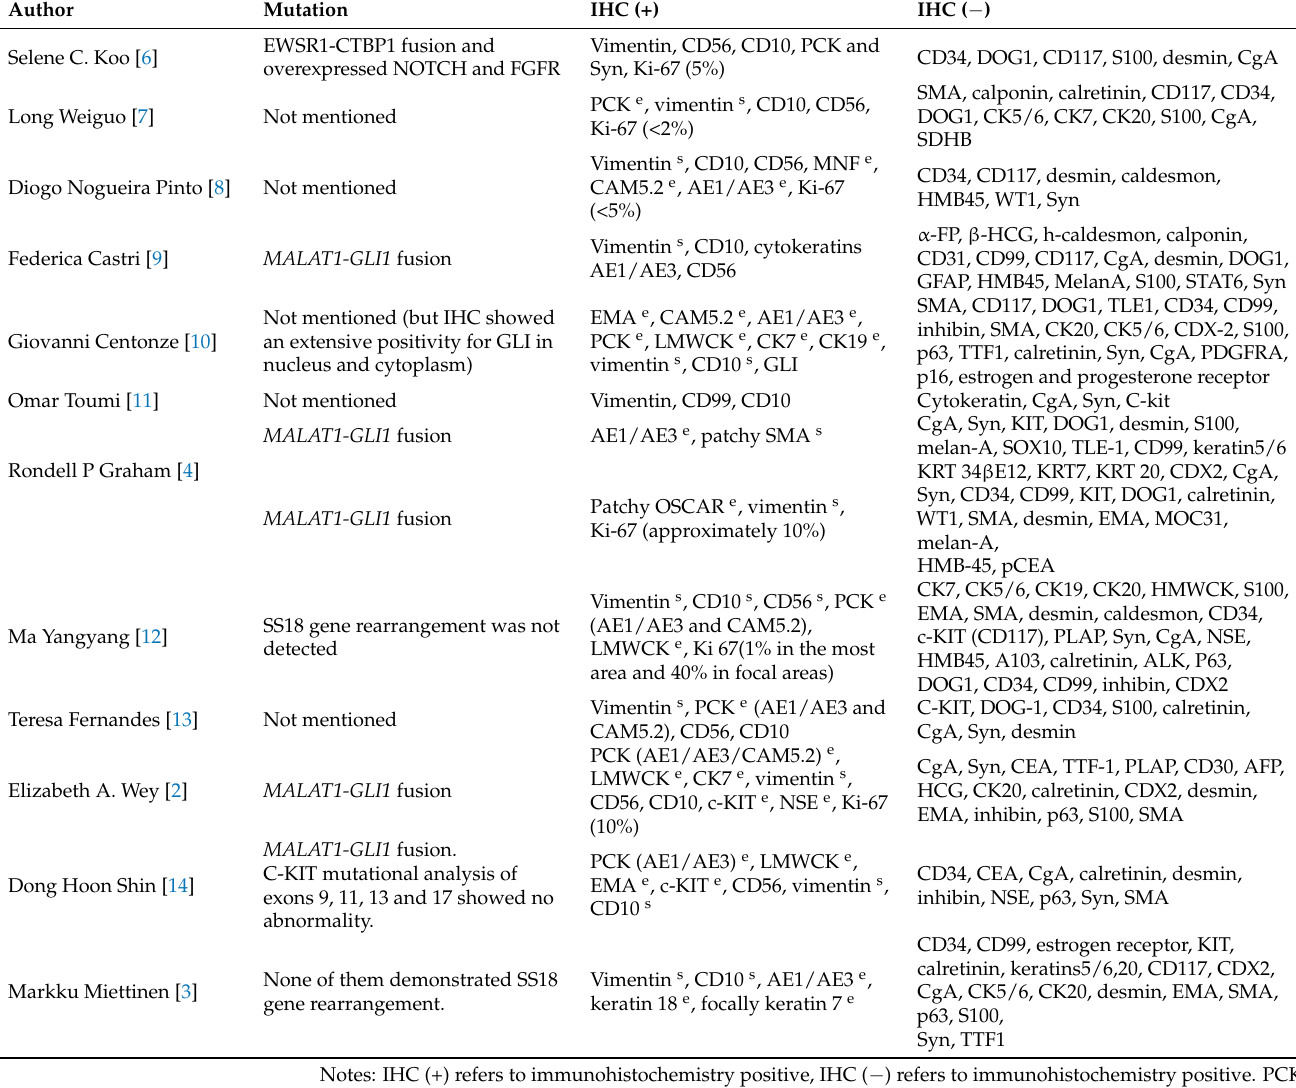
Table 2. Mutation and IHC patterns of